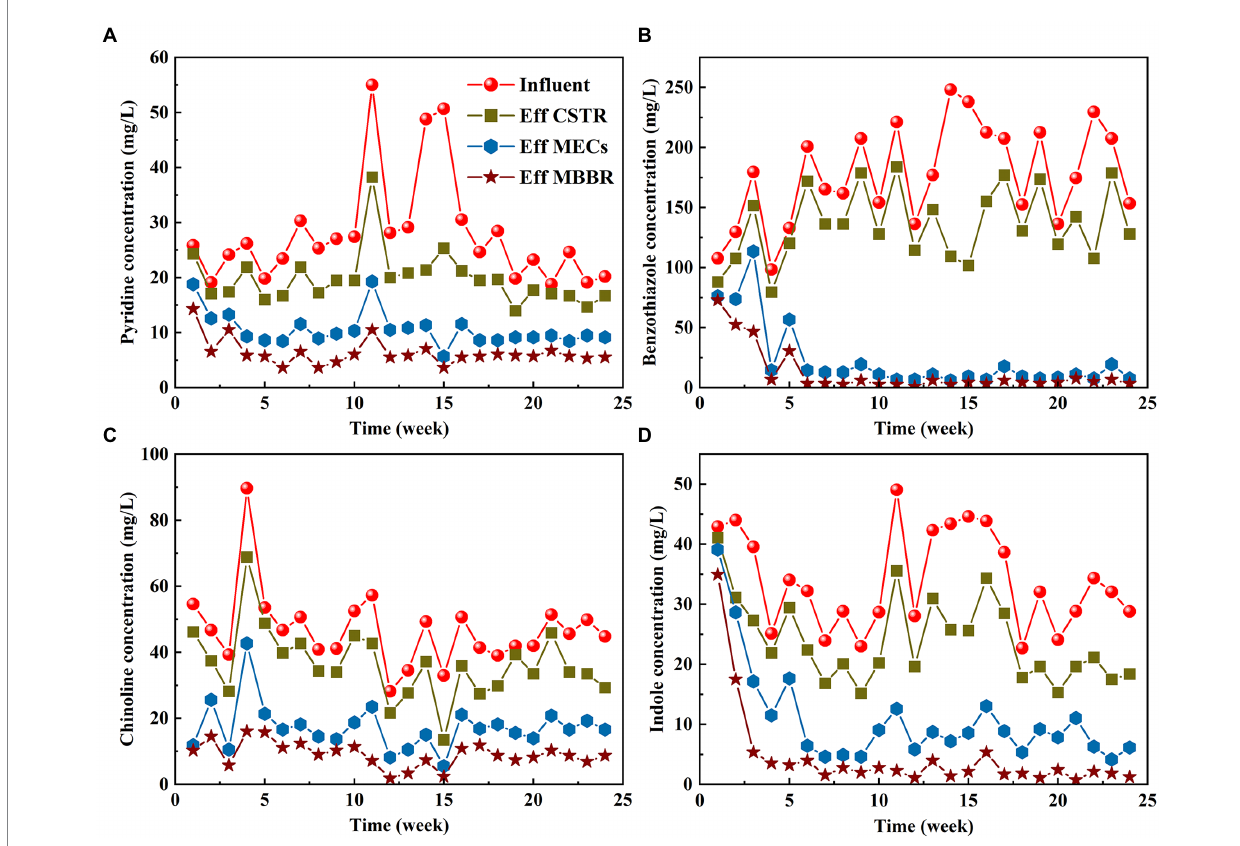
FIGURE 4 Variation of characteristic pollutants: (A) pyridine, (B) benzothiazole, (C) quinoline, and (D)